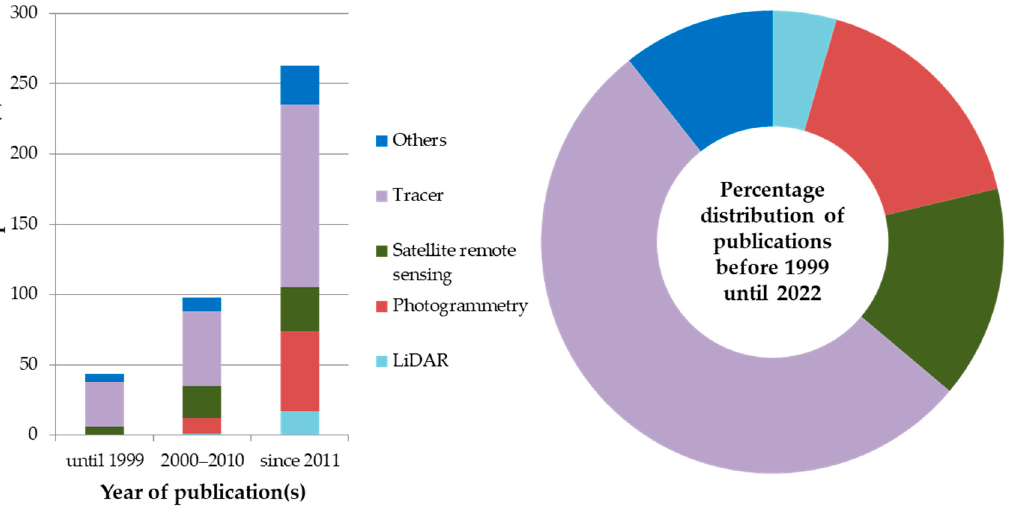
Figure 5. Literature analysis based on the Google Scholar search engine. Search query (28 April 2022) including the name of the assessment techniques (full name, abbreviations) and “erosion” limited to “all in title” findings for the years up to 1999, between 2000 and 2010 and since the year 2011 until now. The analysis includes the number of publications found in each time frame on the left ‐ hand side, and the percentage of the mentioning of each model all together on the right ‐ hand side. LiDAR includes terrestrial and airborne laser scanning. The different categories researched can be found in more detail in Figure 3. The colouring on the left is arranged from the bottom to the top (LiDAR to Others); on the right it starts at the top reading clockwise (LiDAR to Others).